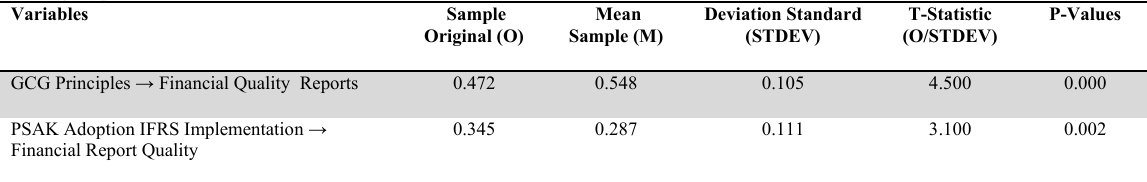
Finding hypothesis